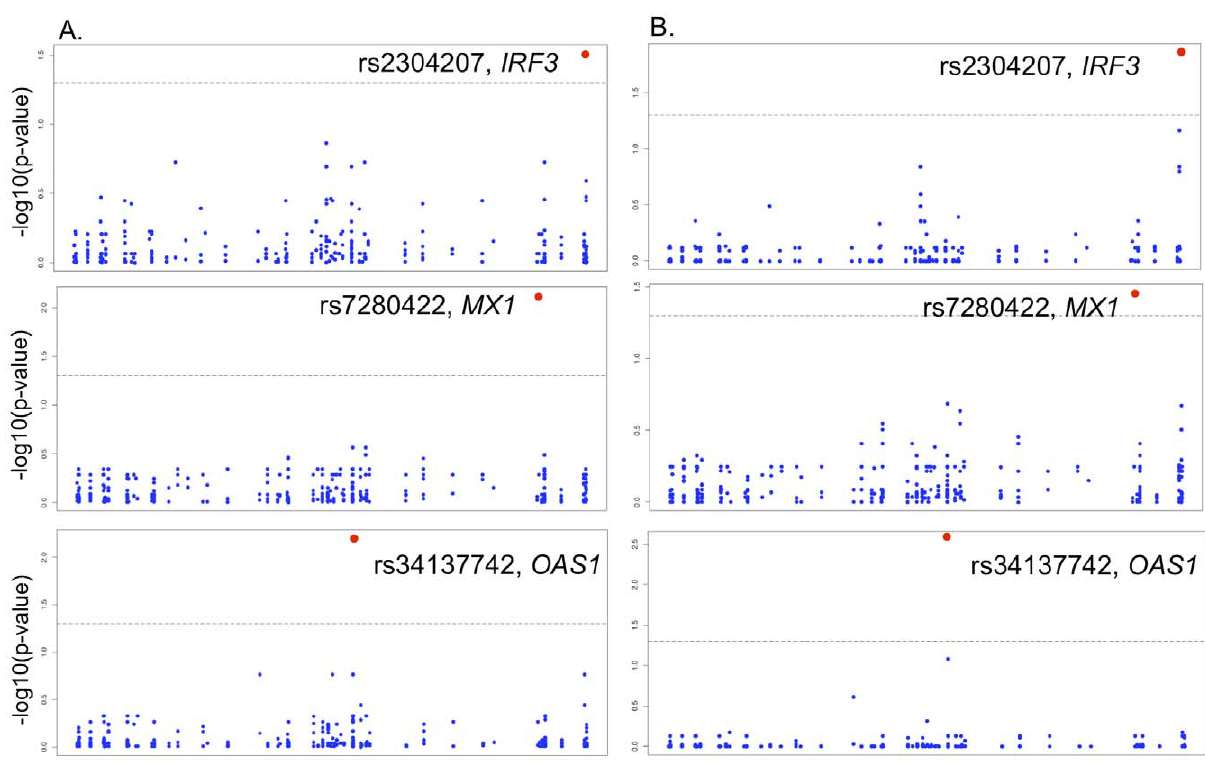
Figure 1. Significant SNPs associated with symptomatic WNV infection or West Nile encephalitis/paralysis (WNE/P). Three SNPs were significantly associated with symptomatic WNV infection and WNE/P. These include rs2304207 in IRF3 for symptomatic cases vs. asymptomatic controls for a dominant inheritance model, rs7280422 in MX1 for symptomatic cases vs. asymptomatic controls for a recessive inheritance model and rs34137742 in OAS1 for WNE/P vs. West Nile fever/meningitis (WNF/M) using a recessive inheritance model. Contingency table results are presented in A whereas results for the logistic regression are shown in B. The horizontal axis for each plot shows the genomic position arranged in order of chromosomal position for each SNP in the dataset. The vertical axis depicts the negative log p-values generated from the chi-square distribution or the logistic regression model analysis. All p-values were corrected for multiple tests using the Bonferroni correction. The black dashed line indicates the five percent significance threshold corrected for multiple tests. No significant SNP associations were identified for WNE/P versus WNF/M for a dominant inheritance model.